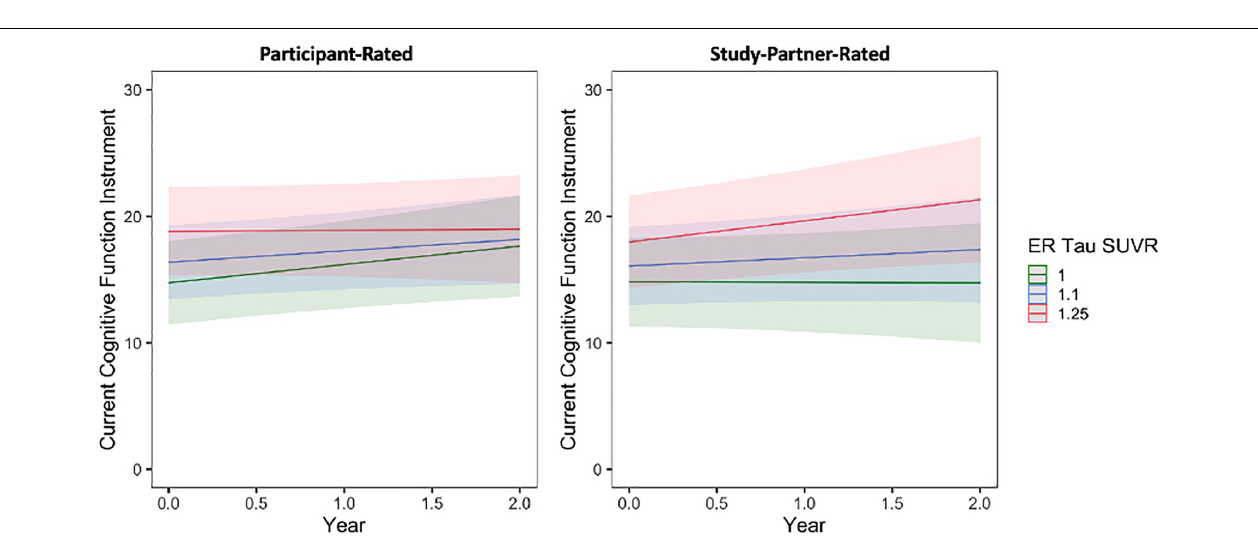
FIGURE 4 | The interaction between baseline participant cerebral amyloid burden (FLR DVR) and time to predict participant-rated (left) and study partner-rated (right) cognitive concerns using the current CFI. A significant interaction was seen between amyloid and time when predicting study partner-rated cognitive concerns (fixed estimate = 4.07, adj. p = 0.0260), in that study partner concerns increased over time in participants with higher amyloid burden at baseline. The interaction between amyloid and time predicting participant-rated cognitive concerns was not significant (fixed estimate = 0.44, adj. p = 0.6350).